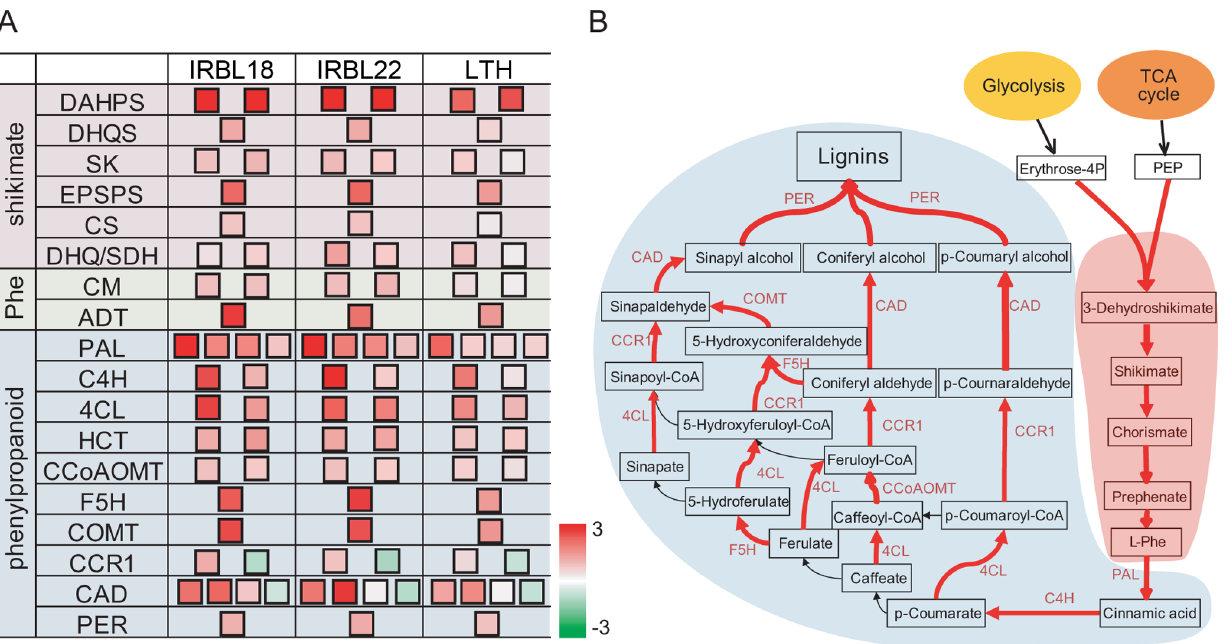
Figure 5. Transcriptional changes in shikimate and phenylpropanoid biosynthesis pathways. A: The expression patterns of genes in the shikimate and phenylpropanoid biosynthesis pathway. The scale bar displays log2-transformed fold changes. B: The metabolic view of shikimate and phenylpropanoid biosynthesis pathways. The steps catalyzed by enzymes encoded by up-regulated genes were shown in red. The shikimate and phenylalanine biosynthesis pathways were highlighted with pink background and the phenylpropanoid biosynthesis pathway was highlighted with light blue background. Gene abbreviations were listed in Table S5.